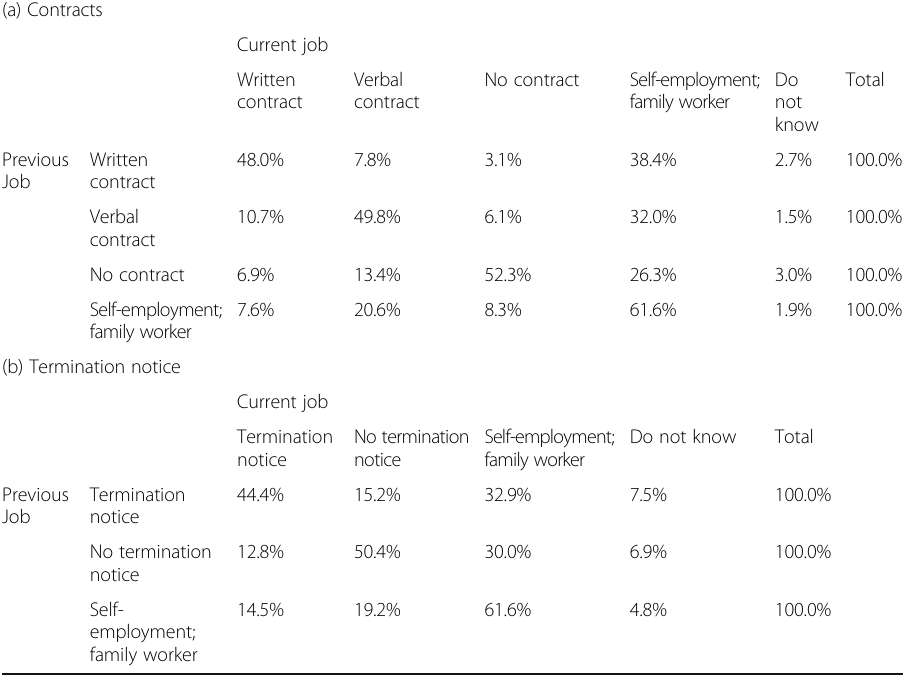
Table 15 Change in access to employment benefits between job transitions (a)